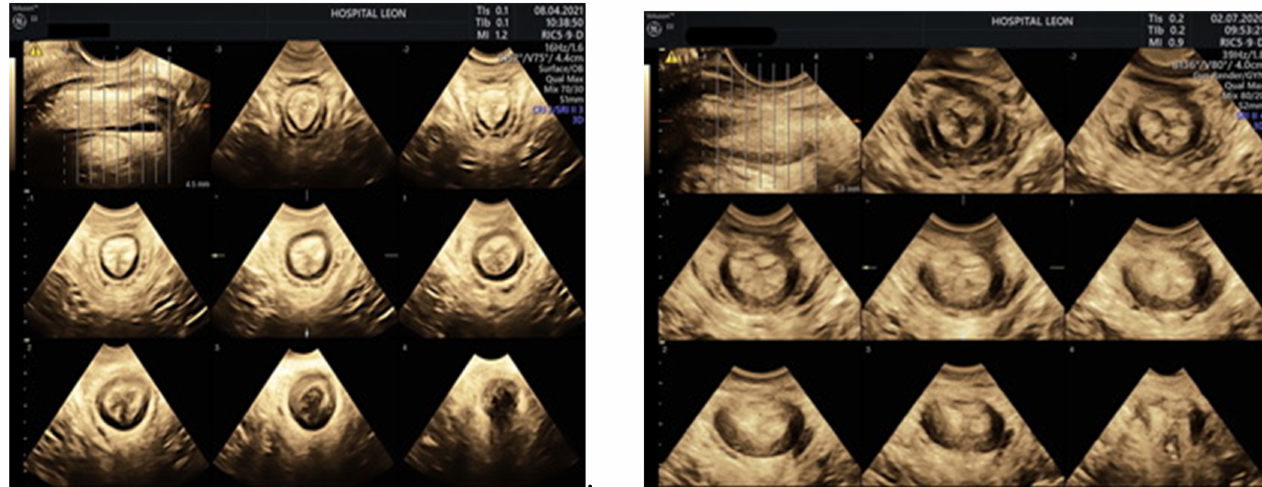
Figure 3. Tomographic ultrasound imaging of internal (IAS) and external anal sphincter (EAS). Longitudinal plane encompassing entire length of EAS is used as reference frame (upper left image of both pictures). The EAS appears as a ring of hyperechogenicity surrounding the thin hypoechogenic ring of the IAS. The mucosal folds of the anal canal appear in the center of the image as the innermost layer. Sphincters are normal in all the transverse slices of the left picture (complete rings). The picture on the right show a full-thickness defect of both sphincters (both concentric rings are